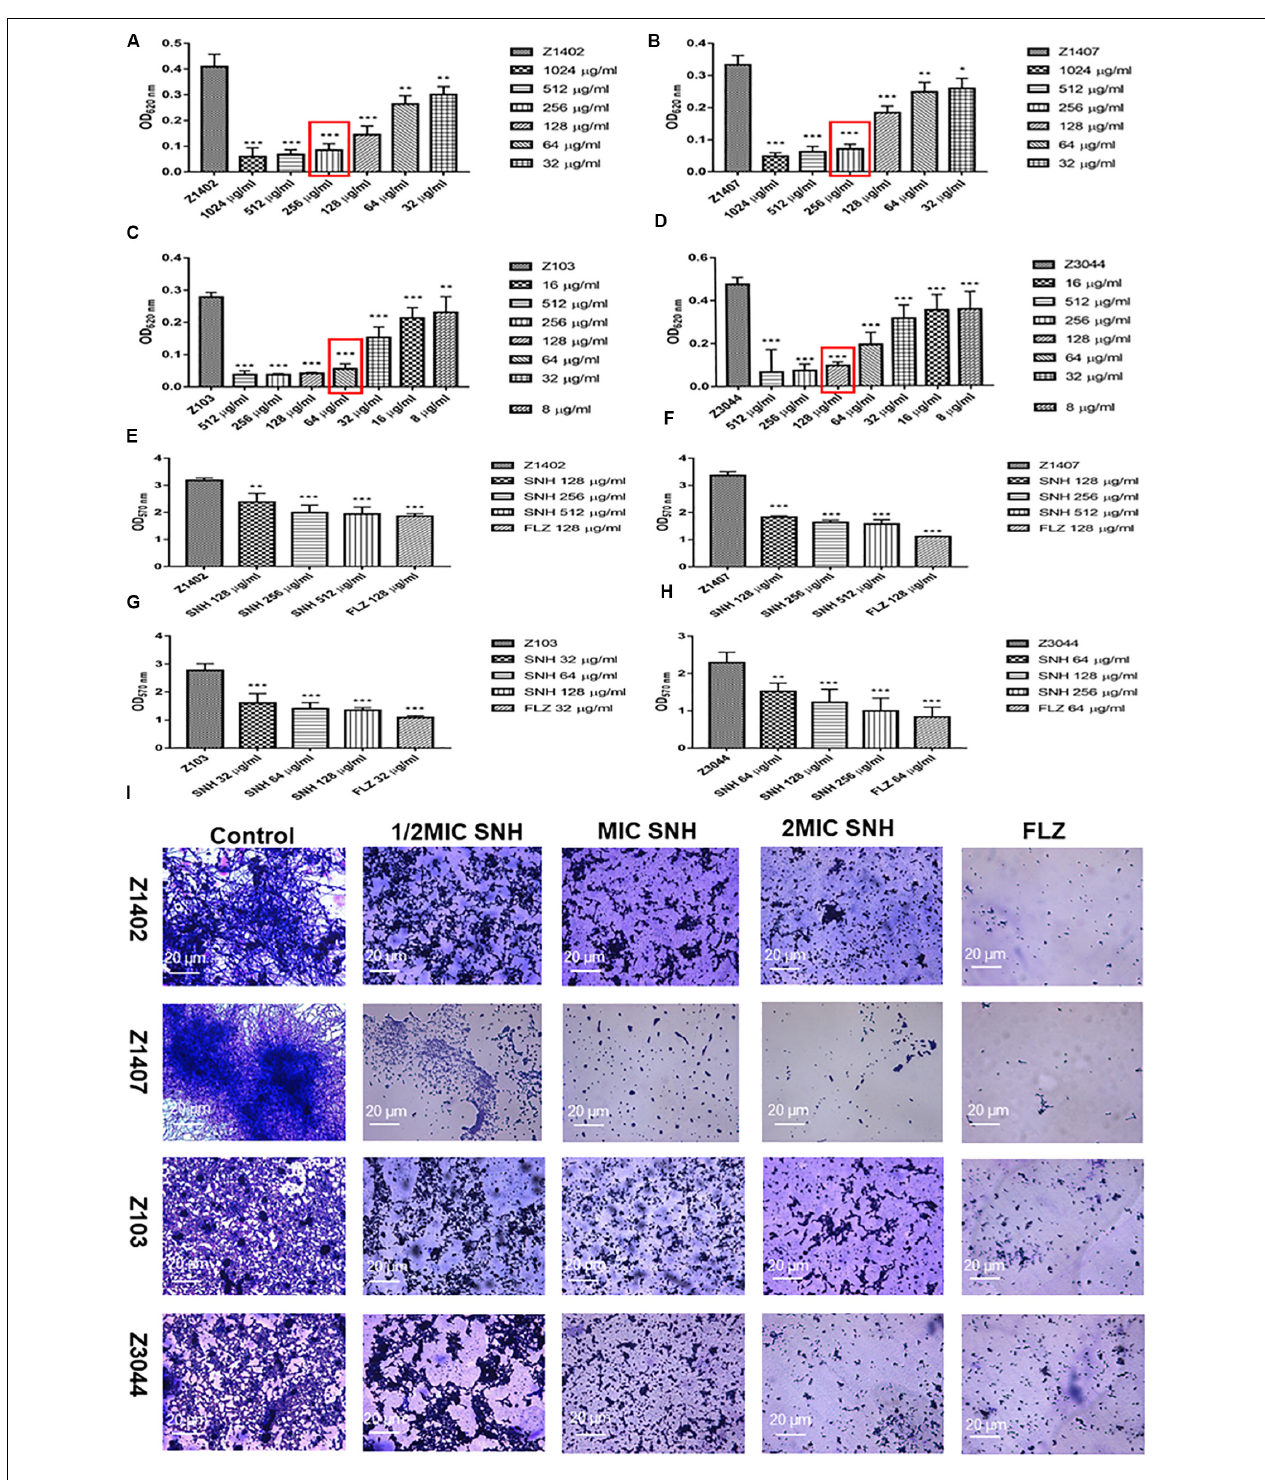
FIGURE 3 | (A–D) Determination of MIC 80 of SNH on C. albicans Z1402, Z1407, Z103, and Z3044 by microdilution method, respectively. The drug-free strain-containing medium was set as the control. Data are shown as mean ± SD. *** p < 0.001, ** p < 0.01, and * p < 0.05, compared with the control. (E − H) Quantitative determination of C. albicans Z1402, Z1407, Z103 and Z3044 biofilm by crystal violet, respectively. The drug-free strain-containing medium was set as the control. Data are shown as mean ± SD. *** p < 0.001 and ** p < 0.01, compared with the control. (I) Crystal Violet Staining of C. albicans Z1402, Z1407, Z103, and Z3044 biofilm by optical microscope ( × 400), respectively. The initial inoculum was newly prepared at 2 × 10 6 CFU/mL. The drug-free strain-containing medium was set as the control.